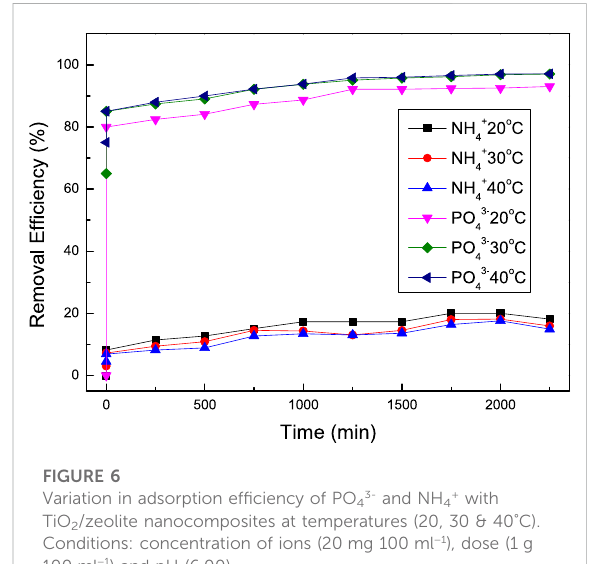
Variation in adsorption ef fi ciency of PO 4 3- and NH 4 + with TiO 2 /zeolite nanocomposites at temperatures (20, 30 & 40 ° C). Conditions: concentration of ions (20 mg 100 ml − 1 ), dose (1 g 100 ml − 1 ) and pH (6.00).